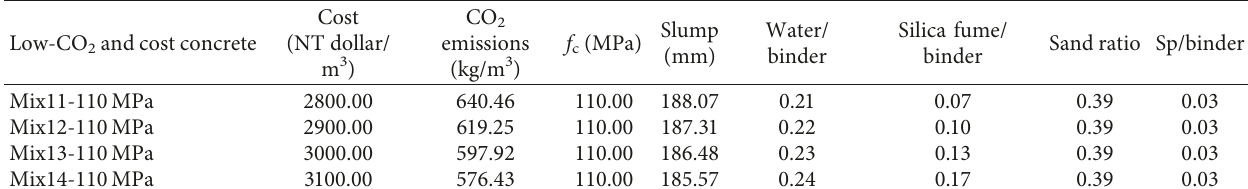
2 emissions and lower cost.